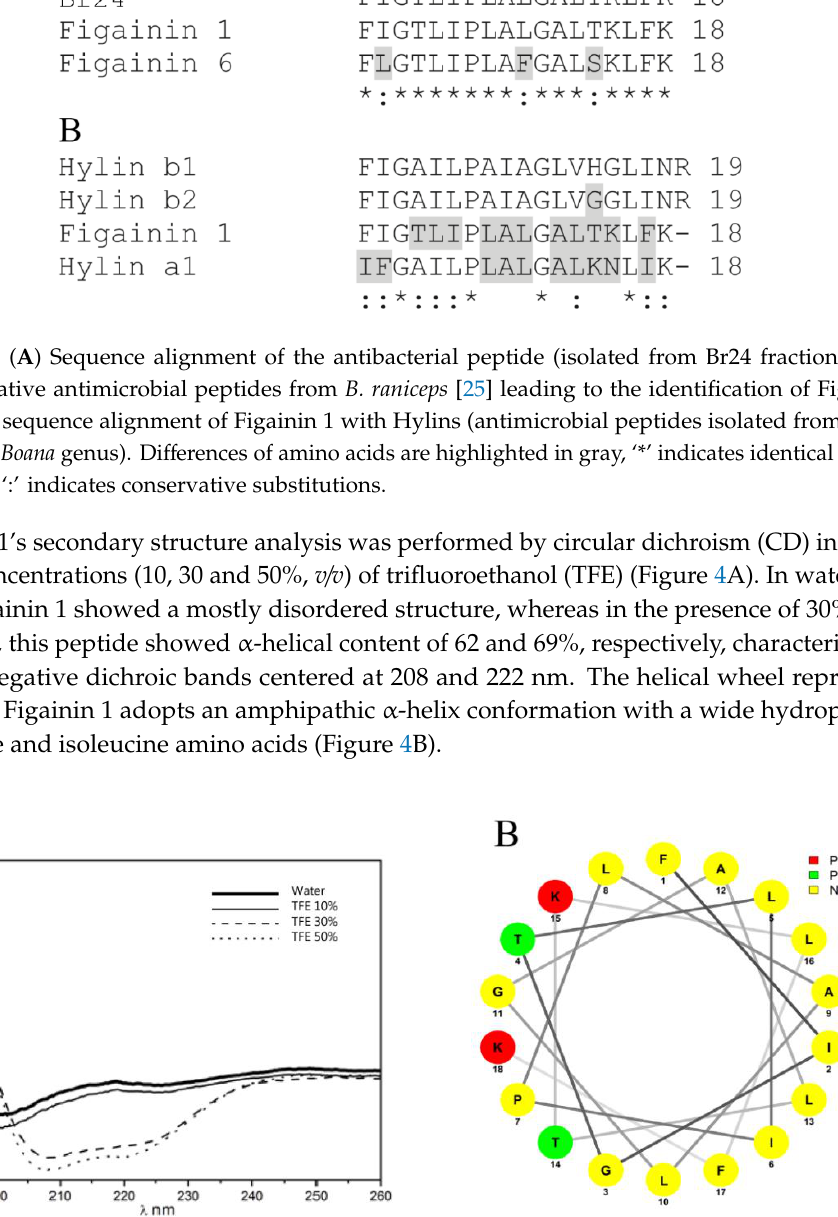
Figure 4. ( A ) Circular dichroism spectra of Figainin 1 dissolved in water and in crescent concentrations (10, 30 and 50%, v/v ) of trifluoroethanol (TFE). ( B ) Helical wheel representation of Figainin 1 illustrating the amphipathic character of the putative